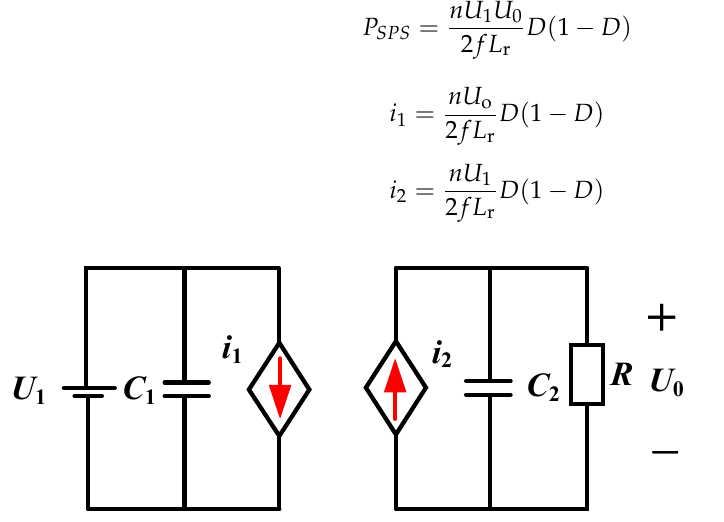
Figure 5. Average model of DAB converter .